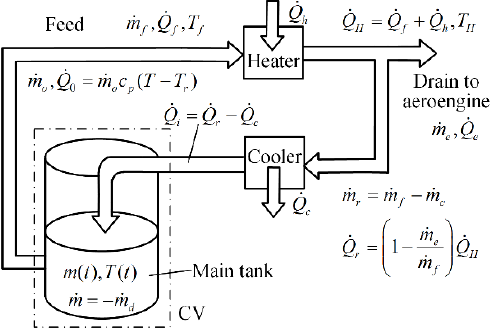
Figure 9. Simplified block diagram of tank with recirculation loop with drain between heat exchanger.